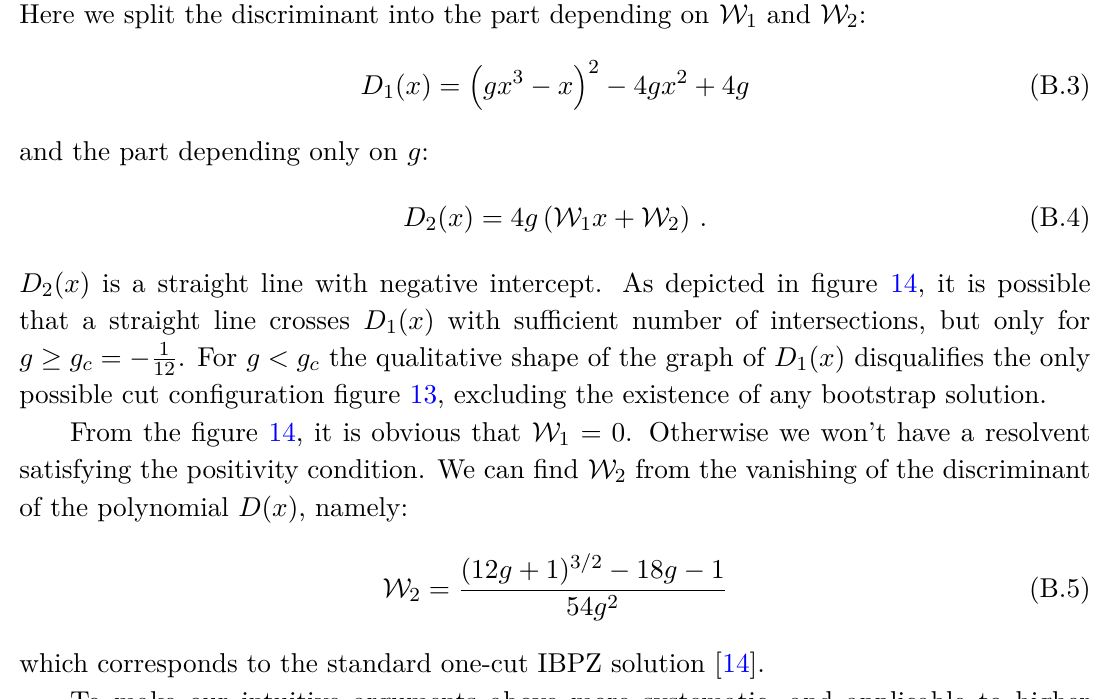
Figure 14 . The only possible cut configuration for µ = 1 and g < 0 . The critical case is g = − 1 below that, there is no more bootstrap